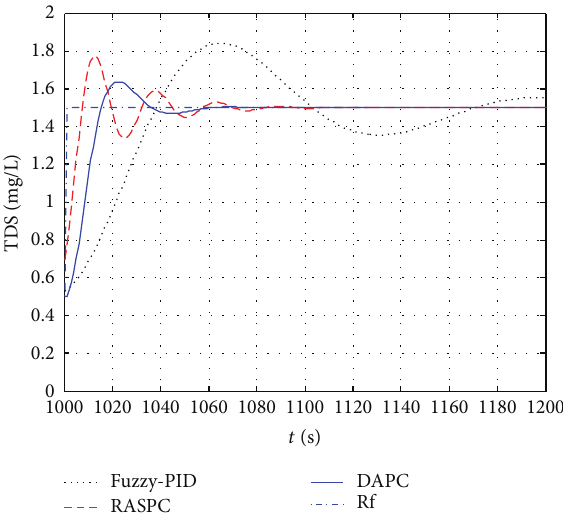
Figure 6: The partial enlarged comparison of Figure 5.